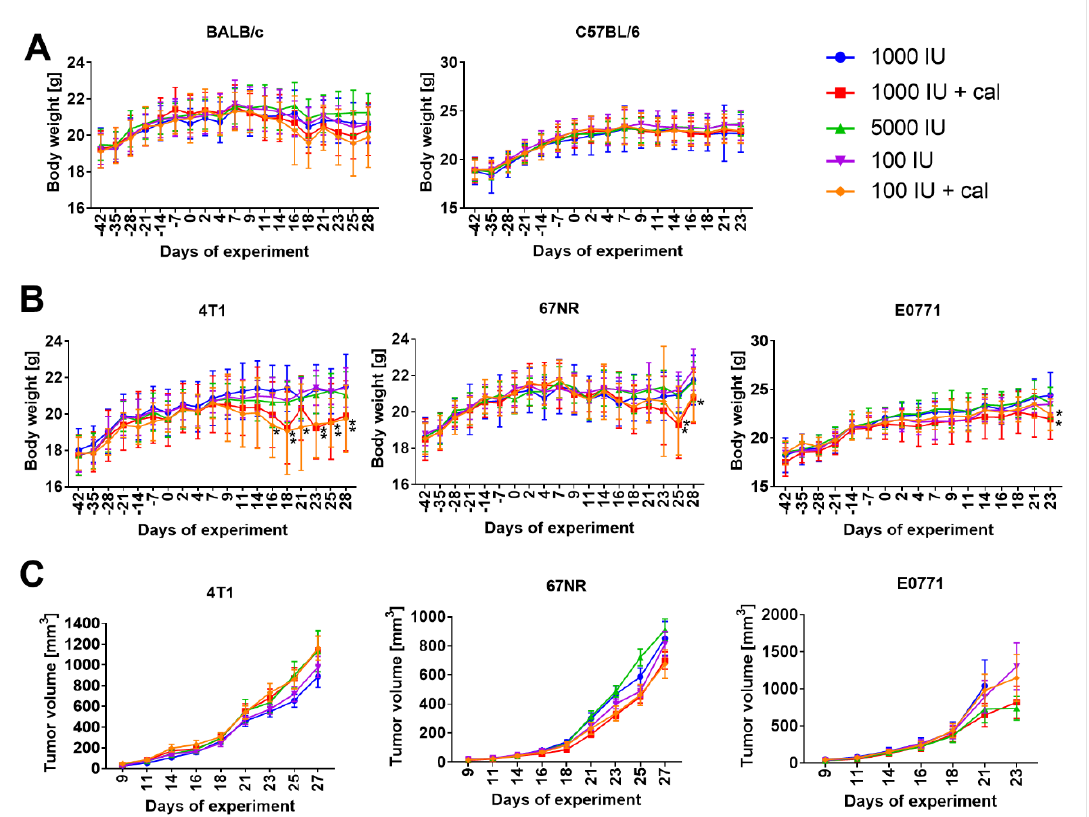
Figure 2. Body weight as well as tumor growth kinetics in BALB/c and C57BL/6 tumor-bearing mice. ( A ) Body weight of healthy BALB/c and C57BL/6 female mice. ( B ) Body weight of tumor-bearing BALB/c (4T1 and 67NR) and C57BL/6 (E0771) female mice. ( C ) Kinetics of tumor growth in BALB/c (4T1 and 67NR) and C57BL/6 (E0771) mice. N = 10–12 mice/group (BALB/c) or 7–12 mice/group (C57BL/6); several mice bearing E0771 tumors were euthanized when tumors reached 2000 mm 3 because of ethical reasons, and thus, there were different numbers of mice at subsequent time-points. Mean values and ( A , B ) standard deviation or ( C ) standard error of mean are presented. Statistical analysis: Sidak’s multiple comparisons test. * p < 0.05 100 IU+cal as compared to 1000 IU; ** p < 0.05 1000 IU+cal and 100 IU+cal as compared to 1000 IU.